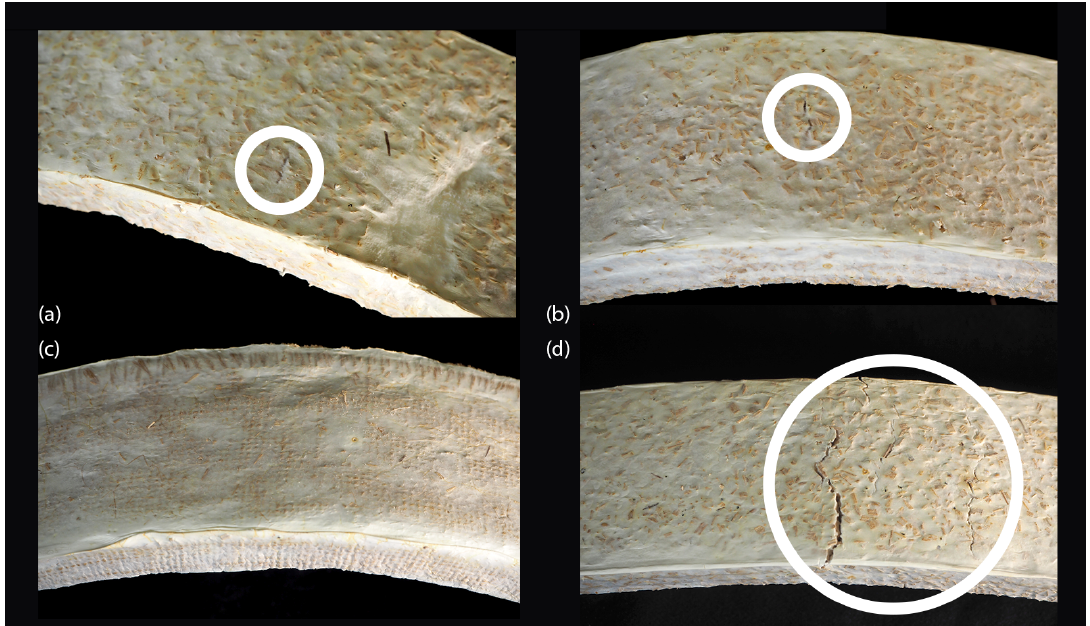
Figure 4. Representative failure modes for the ( a ) BM group, ( b ) BM_I group, ( c ) BM_H group, ( d ) and BM_R